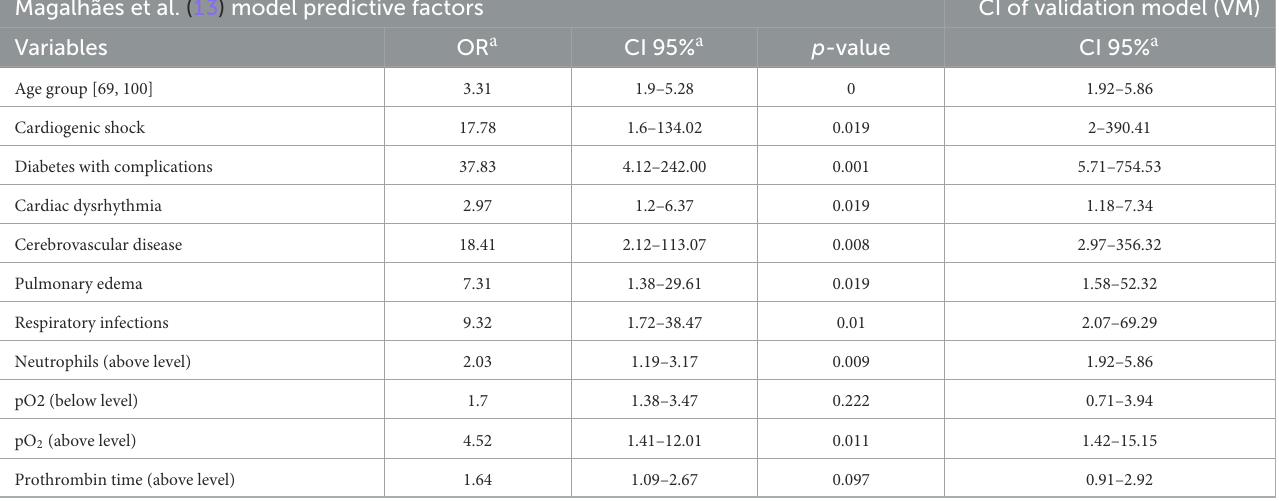
TABLE 4 CI values between the model by Magalhães et al. (13) and the validation model (VM) for AMI. Magalhães et al. (13) model predictive factors CI of validation model (VM)